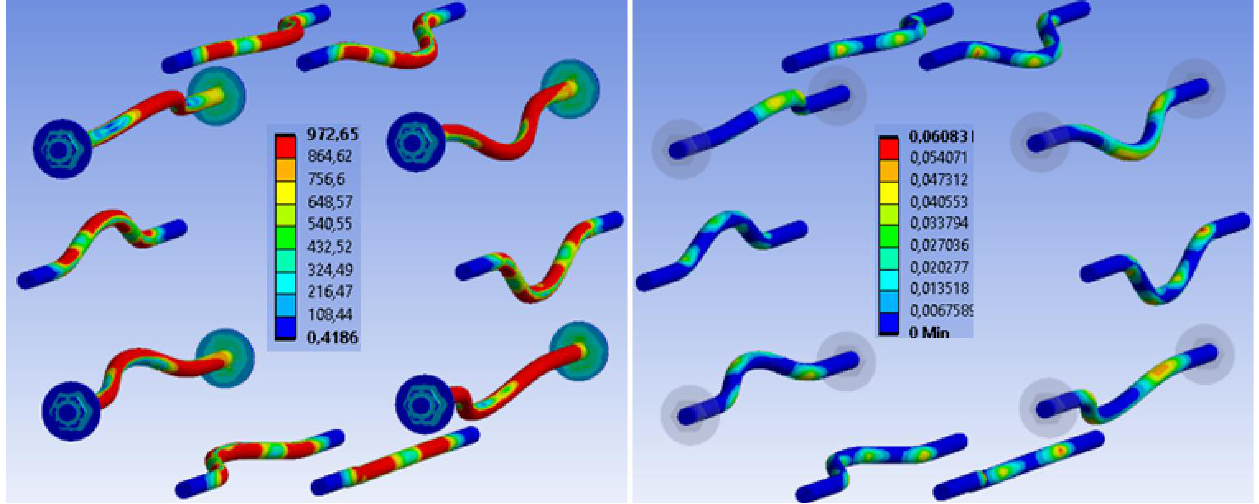
Figure 21. Experiment A: Stress in fasteners during connection collapse (MPa) ( left ), plastic deformation in fasteners during connection collapse (-) ( right ).